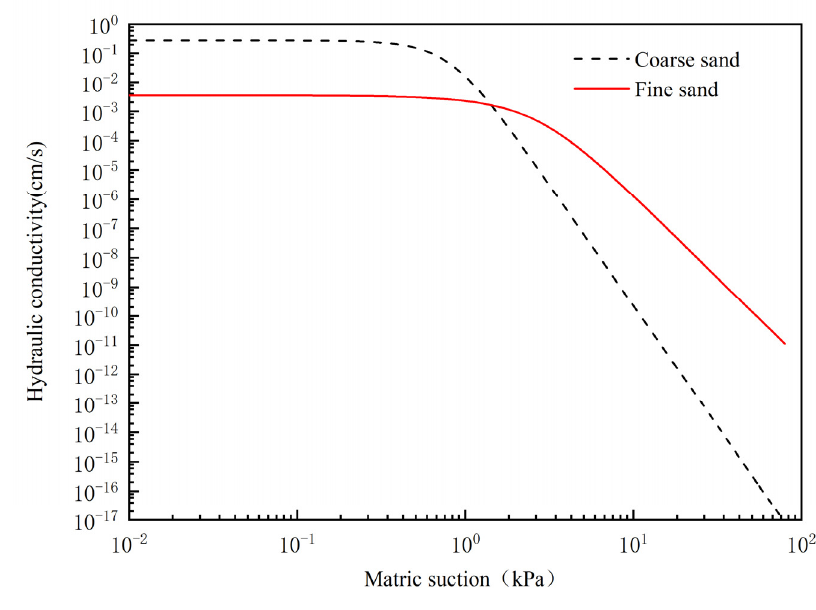
Figure 3. Unsaturated hydraulic conductivity functions for the fine sand and gravelly sand.